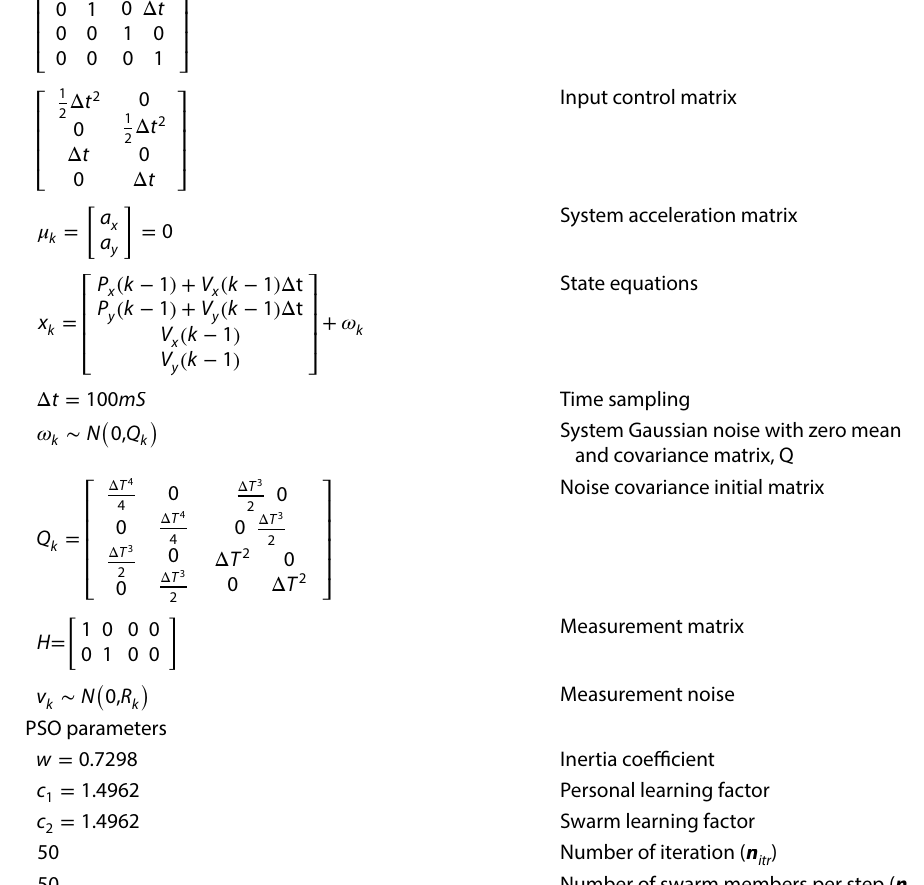
Table 5. Each trajectory is marked with a different sym-